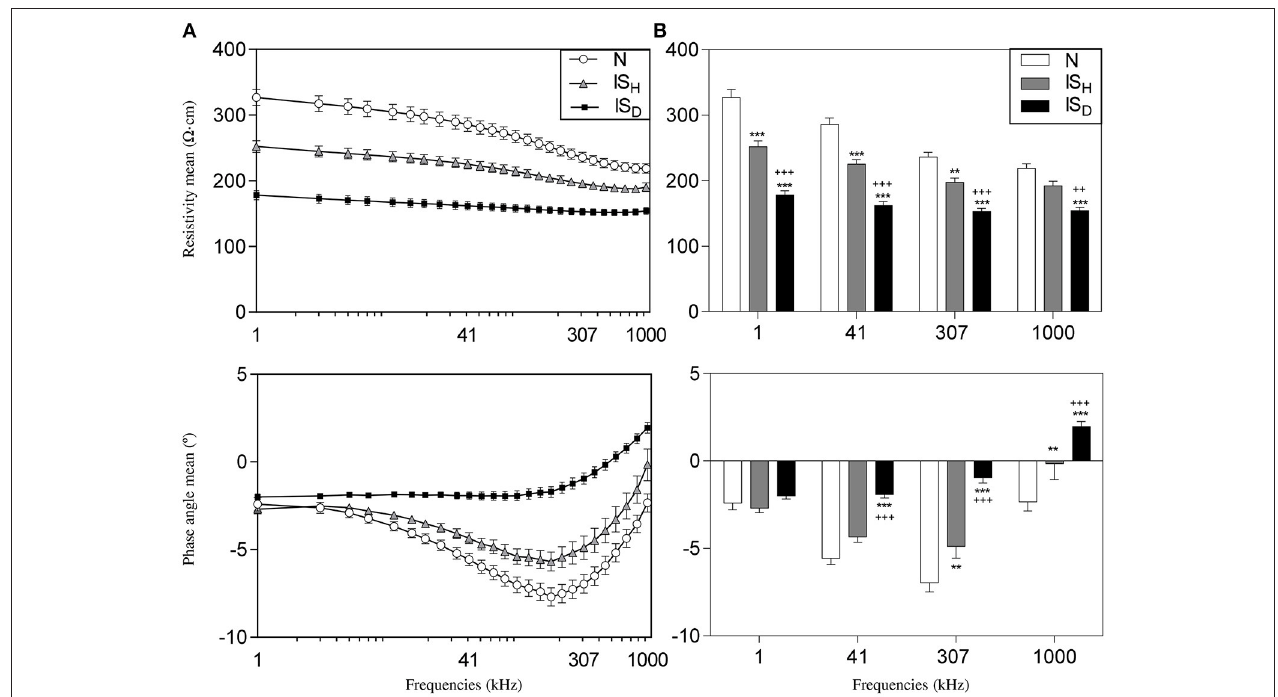
FIGURE 3 | Impedance spectroscopy of 1 month old myocardial infarction in the six studied pigs. (A) Mean values of resistivity (top) and phase angle (bottom) of myocardial impedance at different excitation frequencies in normal (N), heterogeneous (IS H ), and dense infarcted myocardial regions (IS D ). (B) Mean resistivity (top) and phase angle (bottom) at 4 selected frequencies (1kHz, 41kHz, 307 kHz, and 1000kHz). *Significantly different from N (** < 0.01, *** < 0.001). + Significantly different from IS ++ < 0.01, +++ < H (